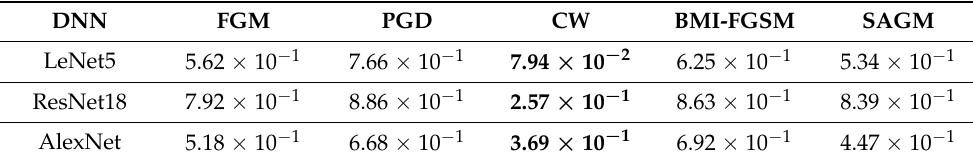
Table 4. SSIM of DNNs.